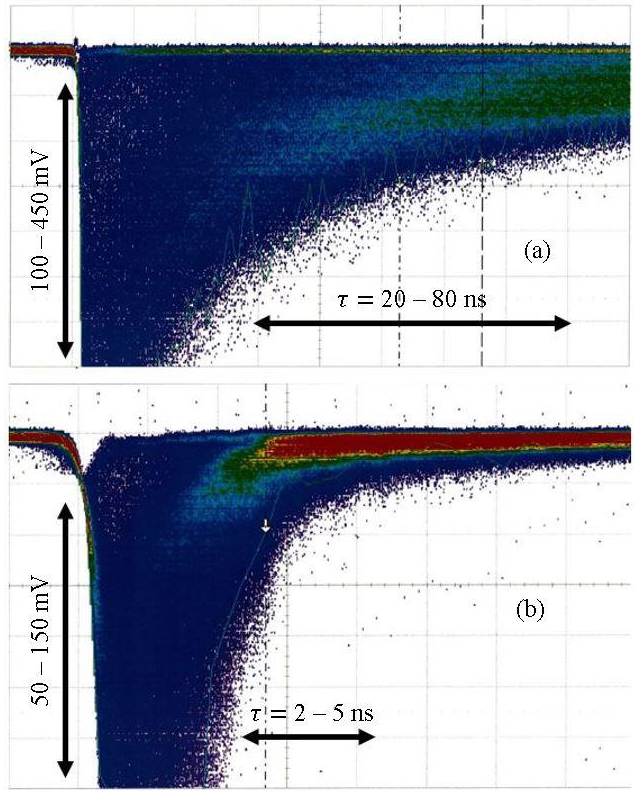
Fig. 1. Alpha pulses (a) and beta pulses (b) obtained from a detector based on plastic and ZnS(Ag).